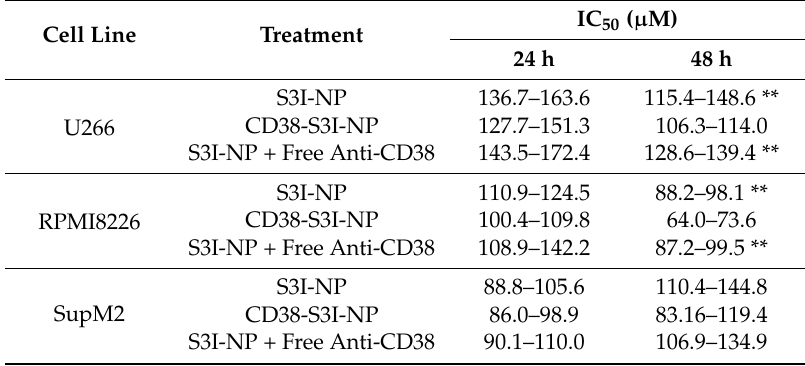
Table 2. IC 50 values of U266, RPMI8226, and SupM2 cells treated with different NP. Cell Line